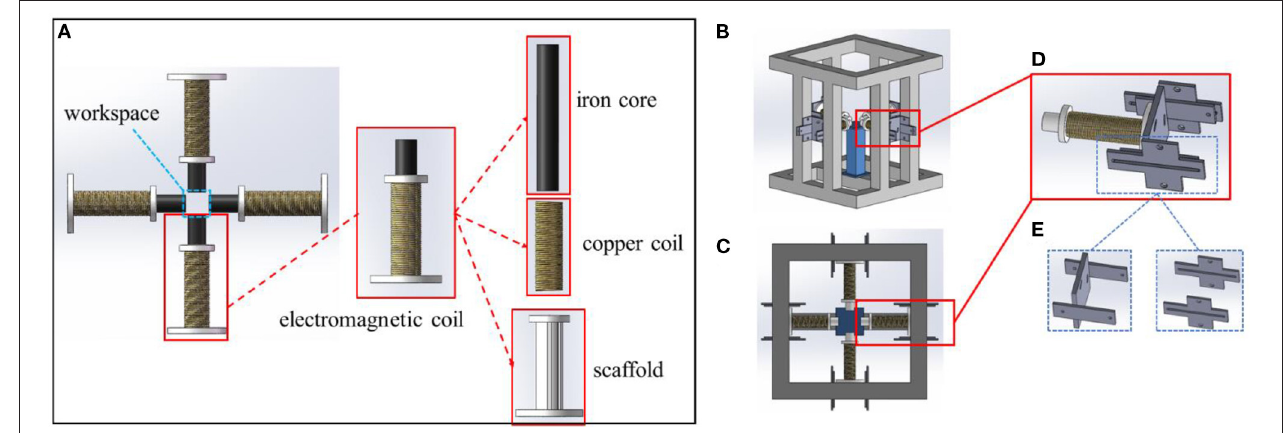
FIGURE 1 | Configuration of the electromagnetic actuated system. (A) Combination of the electromagnetic coils; (B) structure of the entire system; (C) top view of the system; (D) fixation for the electromagnetic coils; (E) H-type bracket and guide